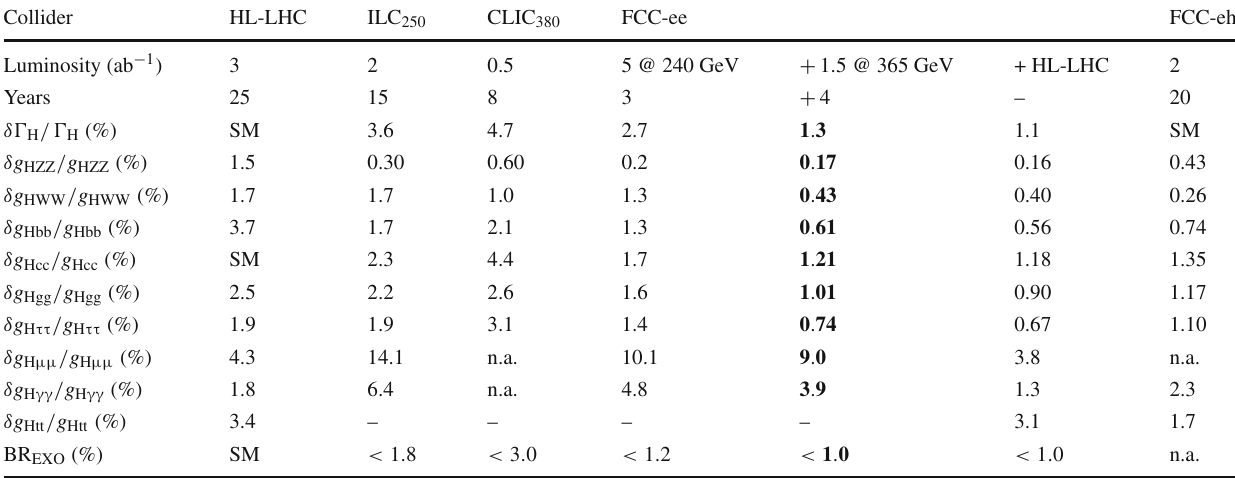
Table S.1 Precisions determined in the κ framework on the Higgs boson couplings and total decay width, as expected from the FCC- ee data, and compared to those from HL-LHC. All numbers indicate 68% C.L. sensitivities, except for the last line which gives the 95% C.L. sensitivityonthe“exotic”branchingfraction,accountingforfinalstates that cannot be tagged as SM decays. The fit to the HL-LHC projections alone (first column) requires assumptions: here, the branching ratios into c ¯ c and into exotic particles (and those not indicated in the table)